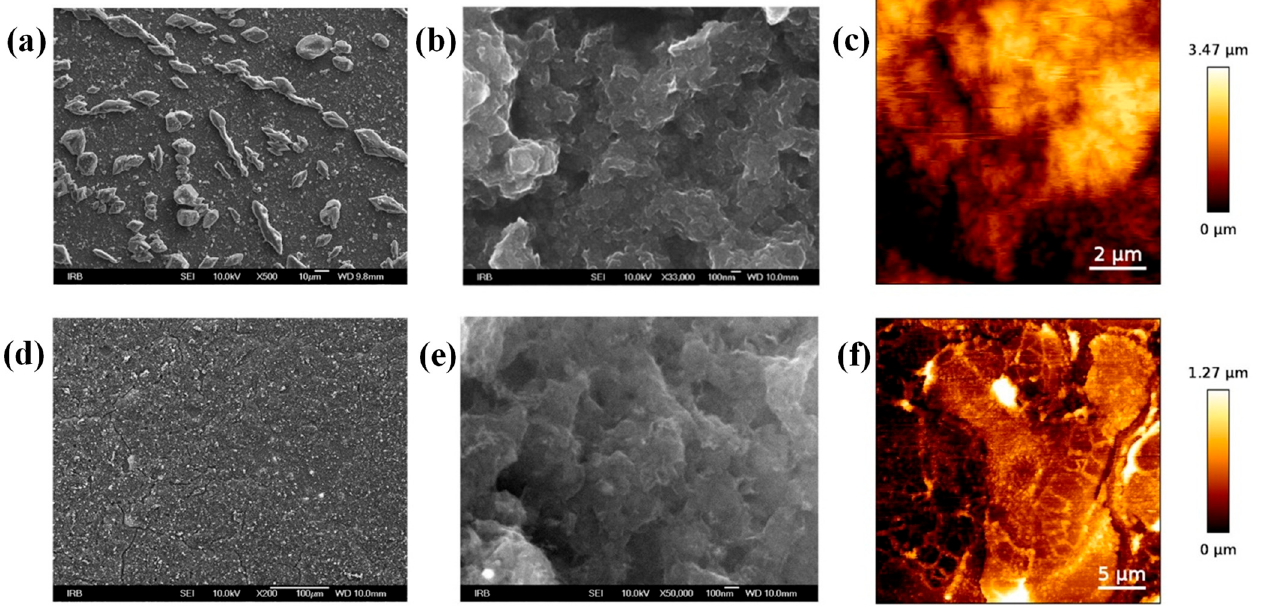
Figure 8. SEM (under different magnification) and AFM images of the M-GNS film on a PI substrate: ( a – c ) before annealing; and ( d – f ) after annealing at 400 °C. ( a – c ) before annealing; and ( d – f ) after annealing at 400 ◦